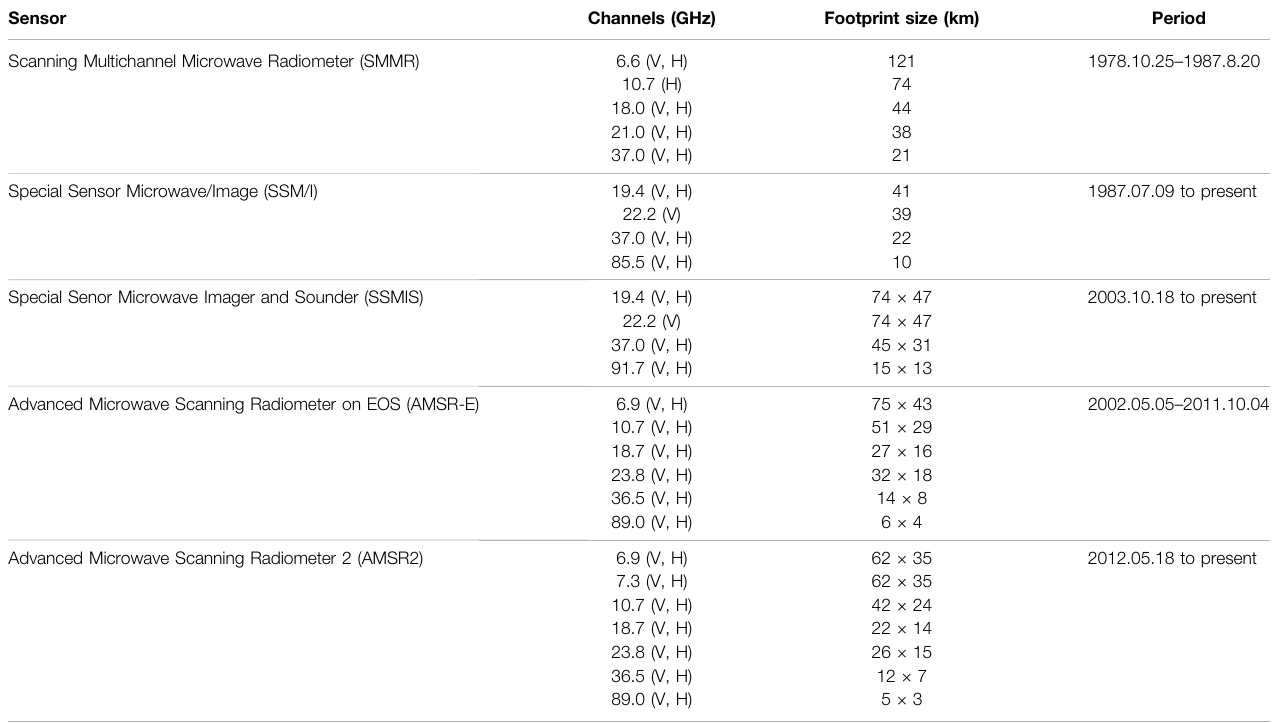
TABLE 1 | Overview of multichannel passive microwave radiation satellite sensors, including vertical (V) and horizontal (H)